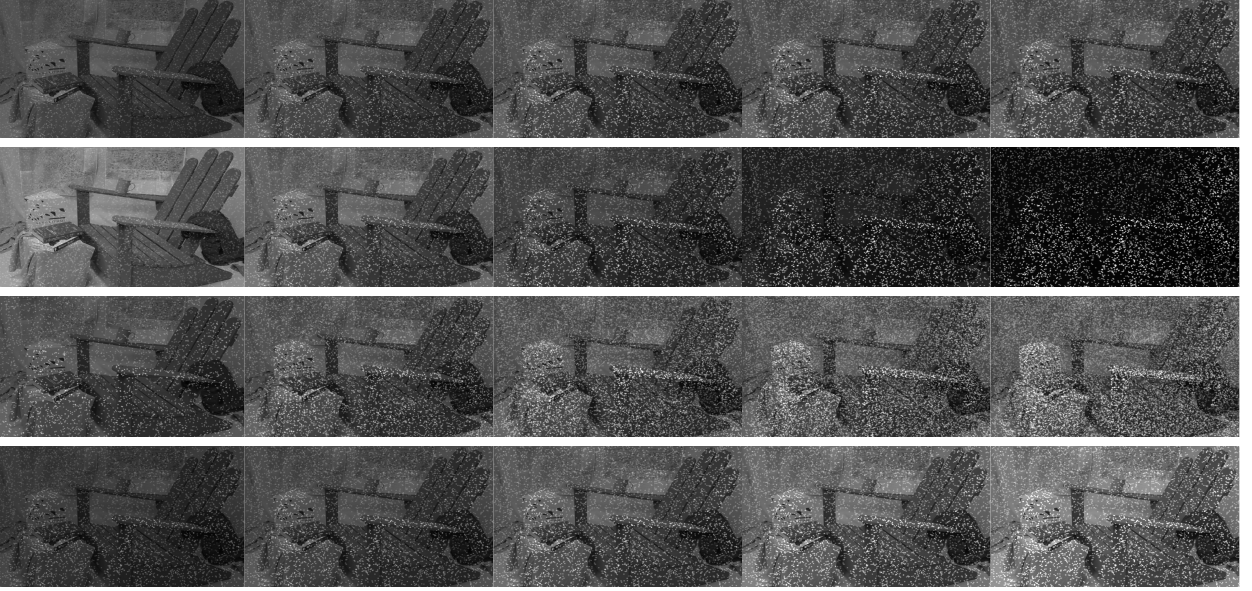
Figure 3. Left synthetic images according to our experimental parameters affecting the attribute of IR images. The figures show changes in the pattern intensity, pattern contrast, number of pattern dots , and global gain from top to